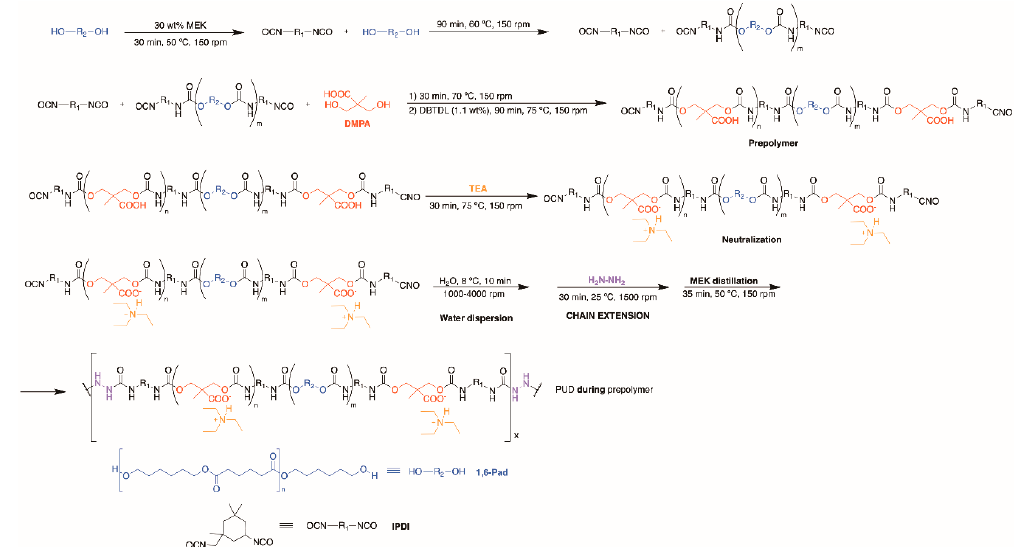
Figure 2. Synthesis of the PUD by adding DMPA during prepolymer formation.